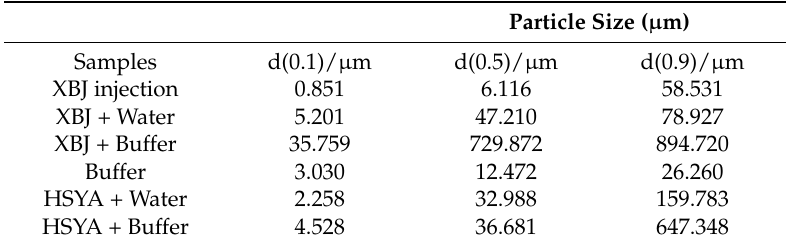
Figure 8. Inverted microscopic images of the original XBJ injection ( a ), buffer solution of XBJ injection ( b ), aqueous solution of XBJ injection ( c ) and HSYA in buffer solution ( d ). Table 5. d(0.1), d(0.5) and d(0.9) values of particle size distribution of HSYA and XBJ in aqueous solution and alkaline